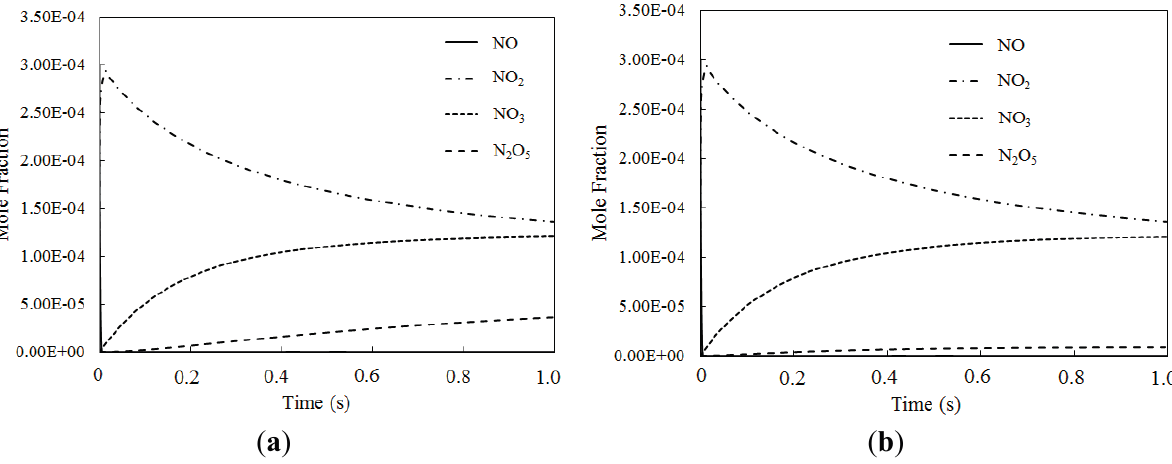
Figure 11. The mole fraction variations of NO, NO 2 , NO 3 and N 2 O 5 at different temperatures where O 3 /NO concentration equals 2 for T = 100 °C and T = 200 °C. ( a ) T = 100 °C; ( b ) T = 200